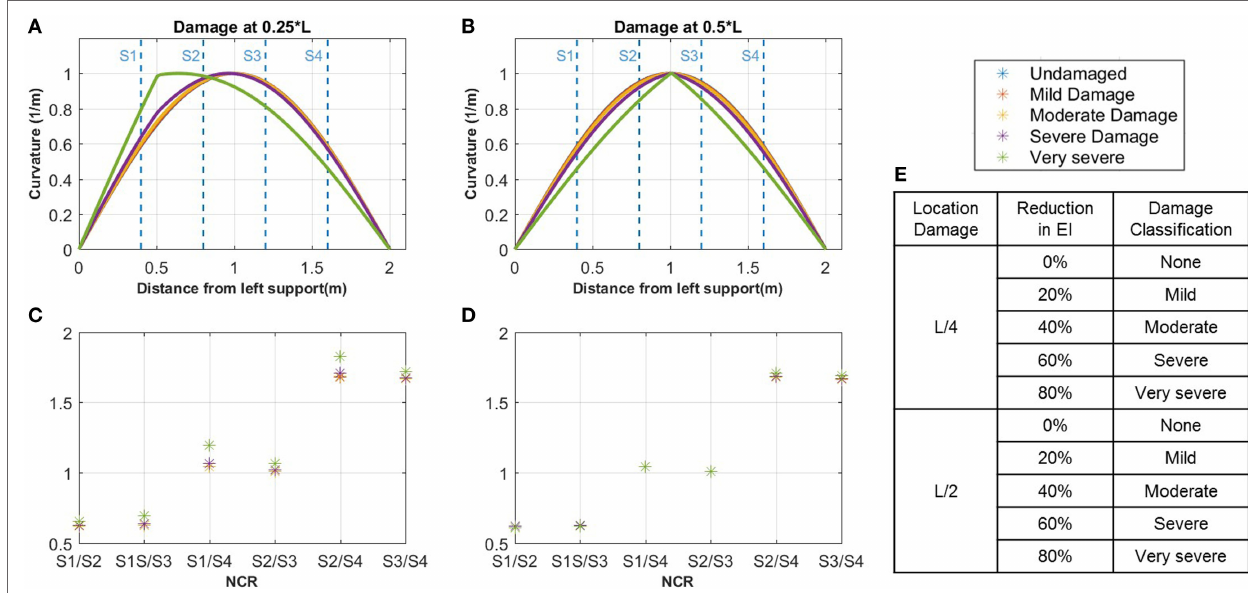
FIGURE 4 | Results from two analytical beam models with loss of stiffness in the cross-section: the curvature (A) and corresponding NCRs (C) for analytical beam with damage located at the quarter-span and the curvature (B) and corresponding NCRs (D) for analytical beam with damage located at the mid-span; (E) Damage classification and corresponding reduction in stiffness